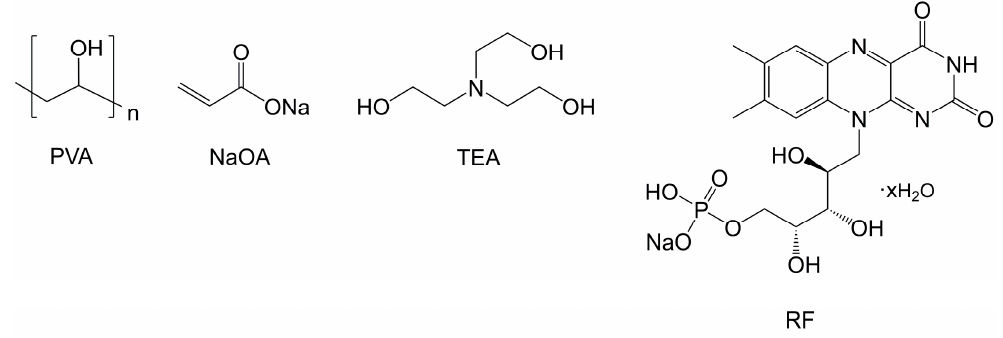
Figure 1. Chemical structures of the prepolymer components.